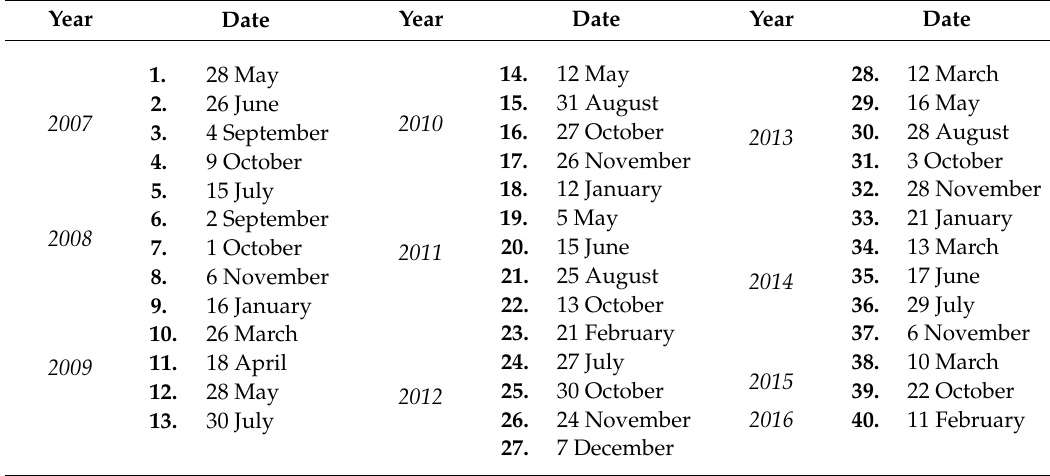
Table 1. Sampling dates at Antares BC station. The sequential numbering in bold is used for reference in the tables in the supplementary